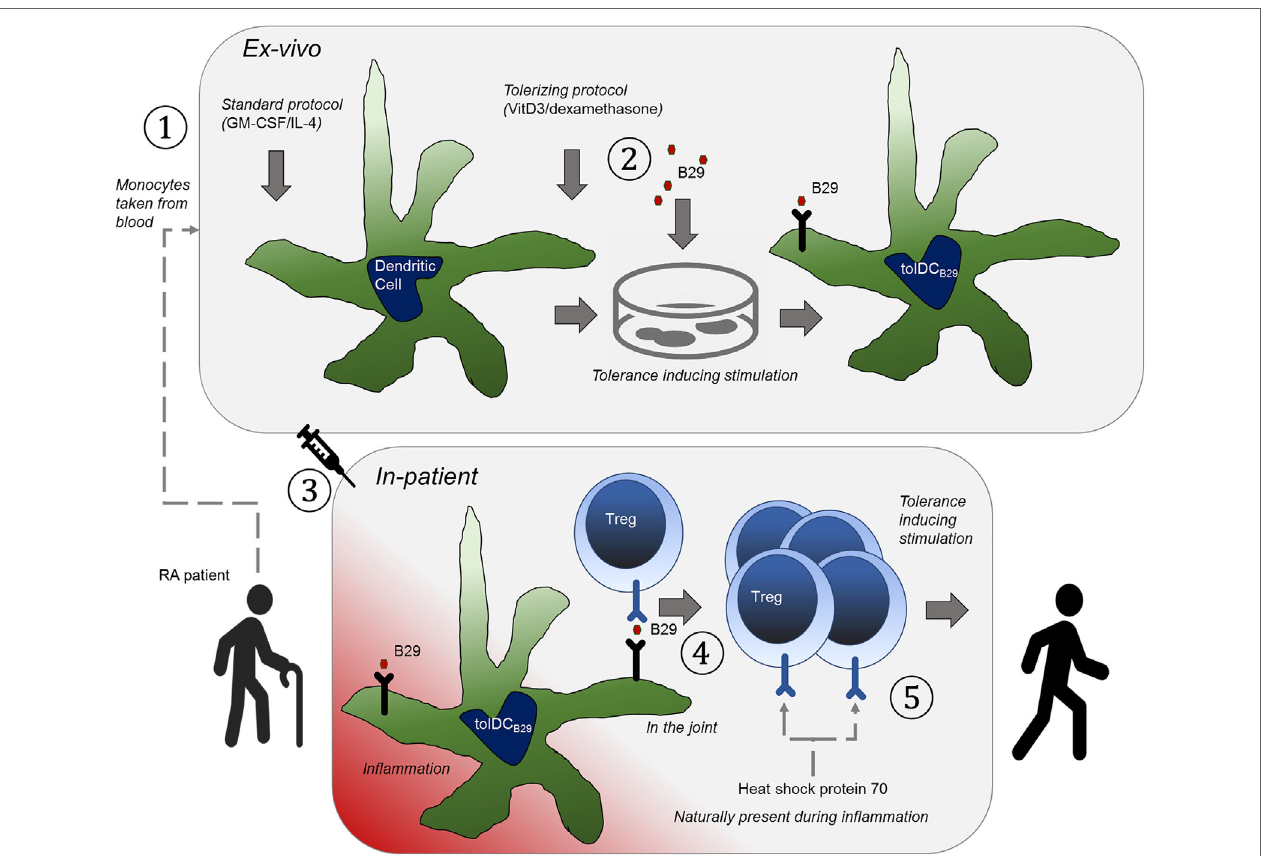
FiGURe 1 | The basic principle that underpins the therapy is to educate tolerance-invoking regulatory T-cells. An orchestrated series of events needs to happen to achieve this and hence to allow it to be an effective approach to treatment of rheumatoid arthritis. (1) Tolerogenic heat shock protein (B29)-specific regulatory T cells (Tregs) are present in the patient, which can be verified with antigen-specific T cell assays. (2) The patient is treated with anti-TNF (or similar) to induce a state of disease remission. (3) Dendritic cells (DCs) are obtained from the patient by expanding peripheral blood obtained monocytes with GM-CSF/IL-4 as growth factors ① , (4) The DCs are ex vivo made into tolerogenic DCs with vitamin D3/dexamethasone and loaded with B29 ② , so that they can present this epitope to regulatory T cells. (5) The cells are re-introduced into the patient ③ (remission allows for better tolerance induction). (6) The epitope is presented to Tregs by the tolerogenic DCs ④ , to activate the regulatory T cells. (7) The patient now has a Treg repertoire that naturally suppresses inflammation ⑤ (in the